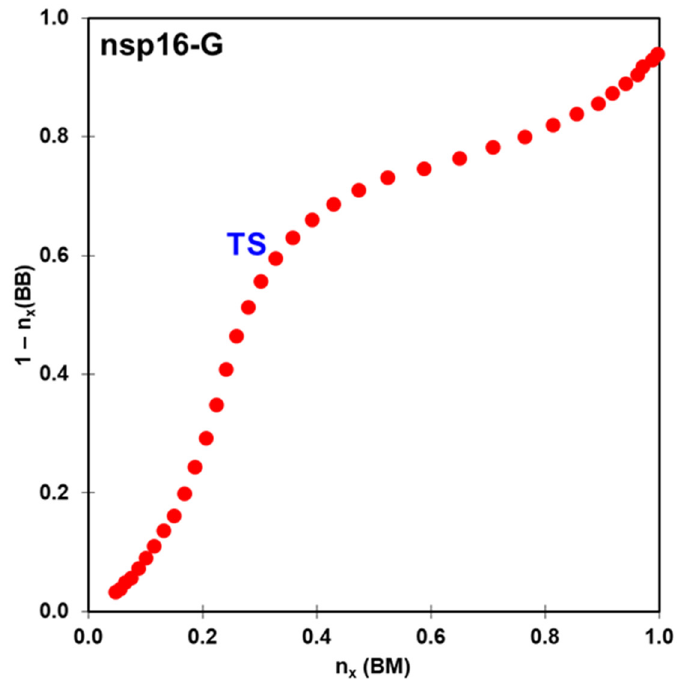
Figure 5. Evolution of O1–C1 bond order, n x , for the S N 2 mechanism of the nsp16-A ( top ) and nsp16-G ( bottom )